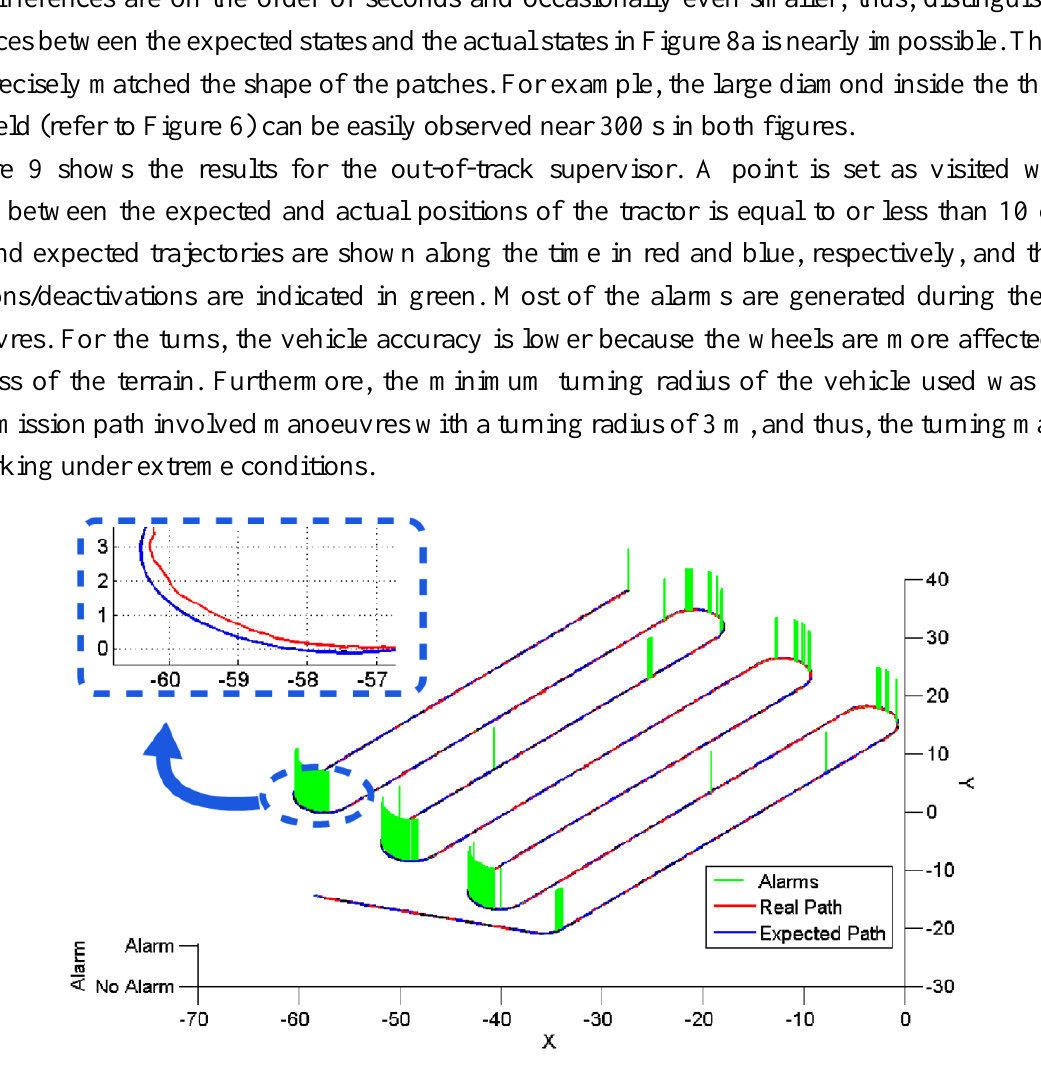
Figure 9. Out-of-track supervisor inputs (actual and expected trajectory) and outputs (alarm).